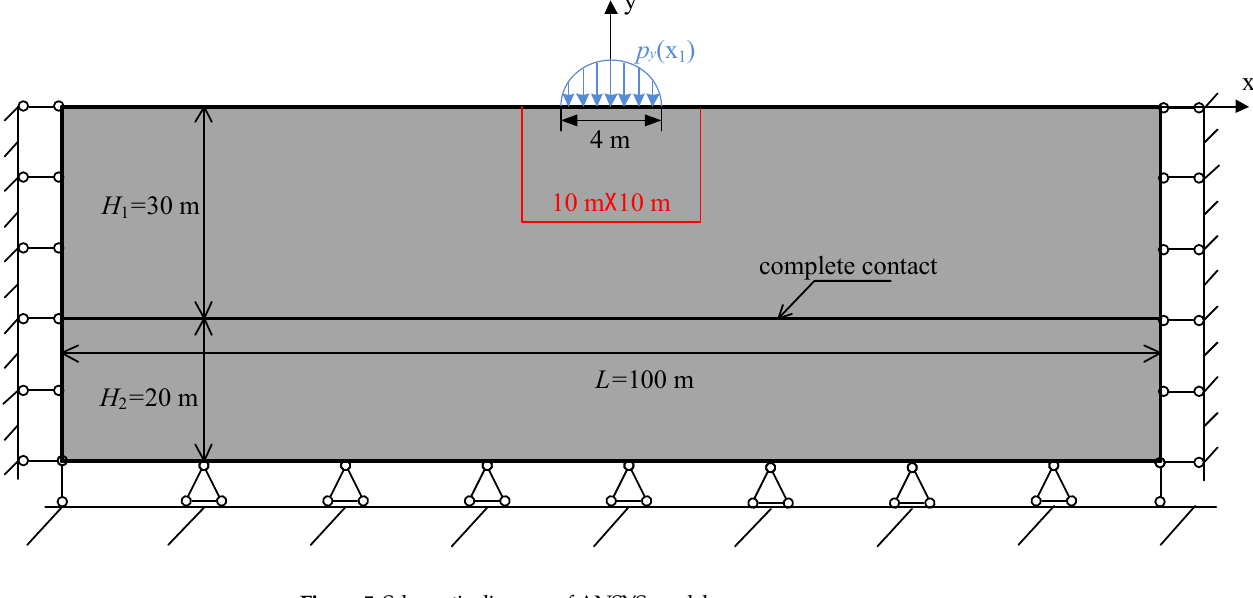
Figure 5. Schematic diagram of ANSYS model.